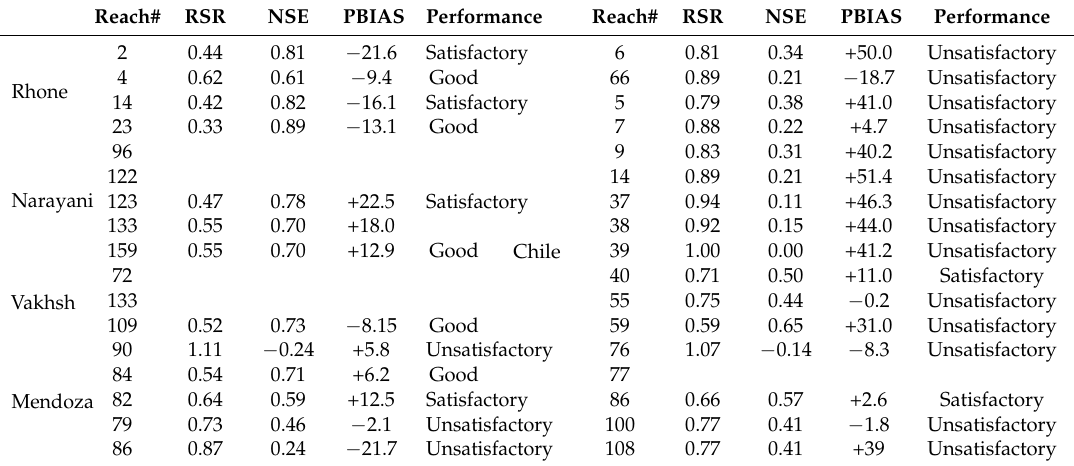
Table 9. Model performance by modified snow algorithms for validation